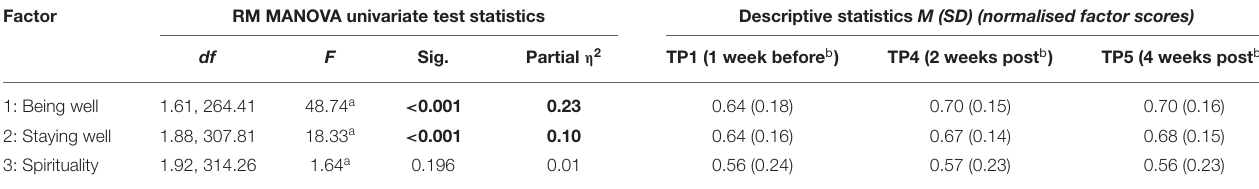
TABLE 6 | Relevant statistics for Repeated Measures Multivariate Analysis of Variance (RM MANOVA) with factor scores. Factor RM MANOVA univariate test statistics Descriptive statistics M (SD) (normalised factor